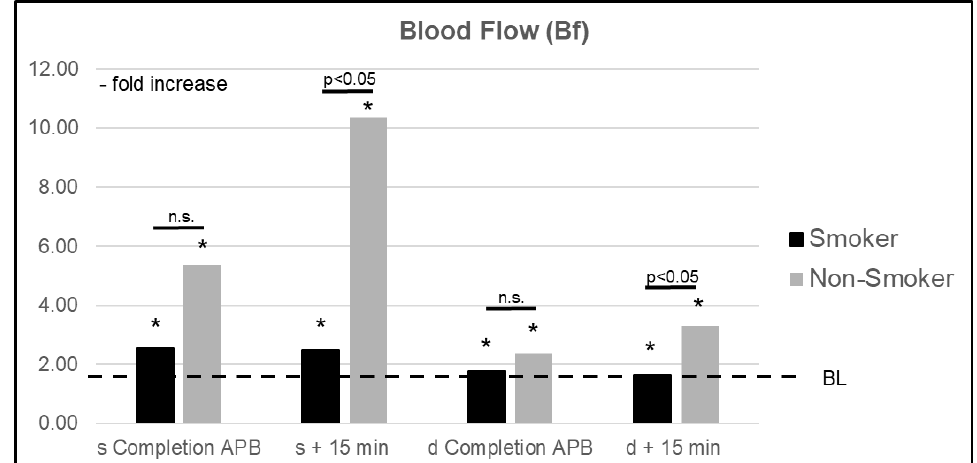
Figure 5. Relative increase in mean superficial (s) and deep (d) blood flow (Bf) in smokers vs. nonsmokers right after completion of the axillary plexus blockade (APB) and after an additional 15 min. BL = baseline value, n.s. = nonsignificant, * significant change compared to